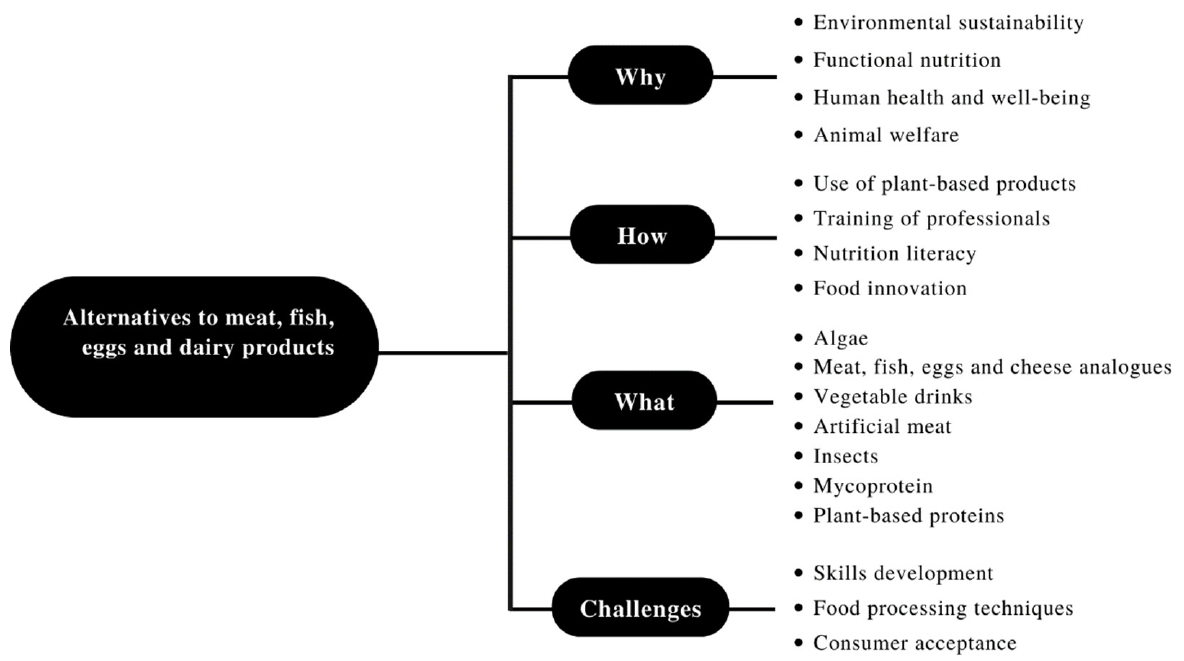
Figure 1. Outlook about main issues related to alternatives to meat, fish, eggs and dairy products in the food industry.